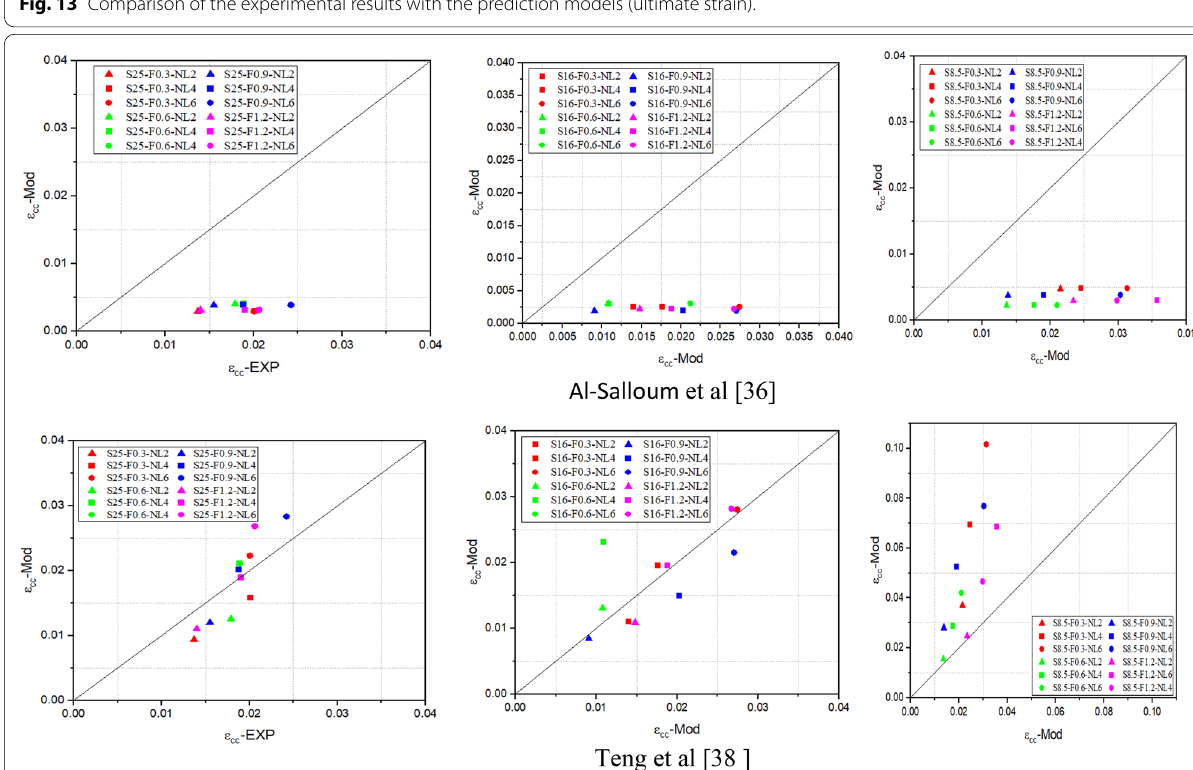
Fig. 13 Comparison of the experimental results with the prediction models (ultimate